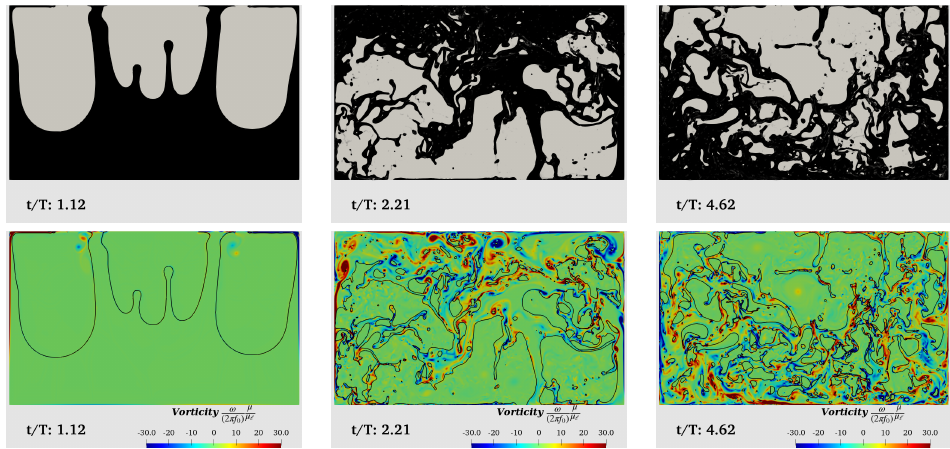
Figure 22. Two-dimensional water E LEMENTAL ® results on the N 200 resolution at various time instants. The top row shows the VOF with the water black and air white. The bottom row shows the non-dimensionalized vorticity.